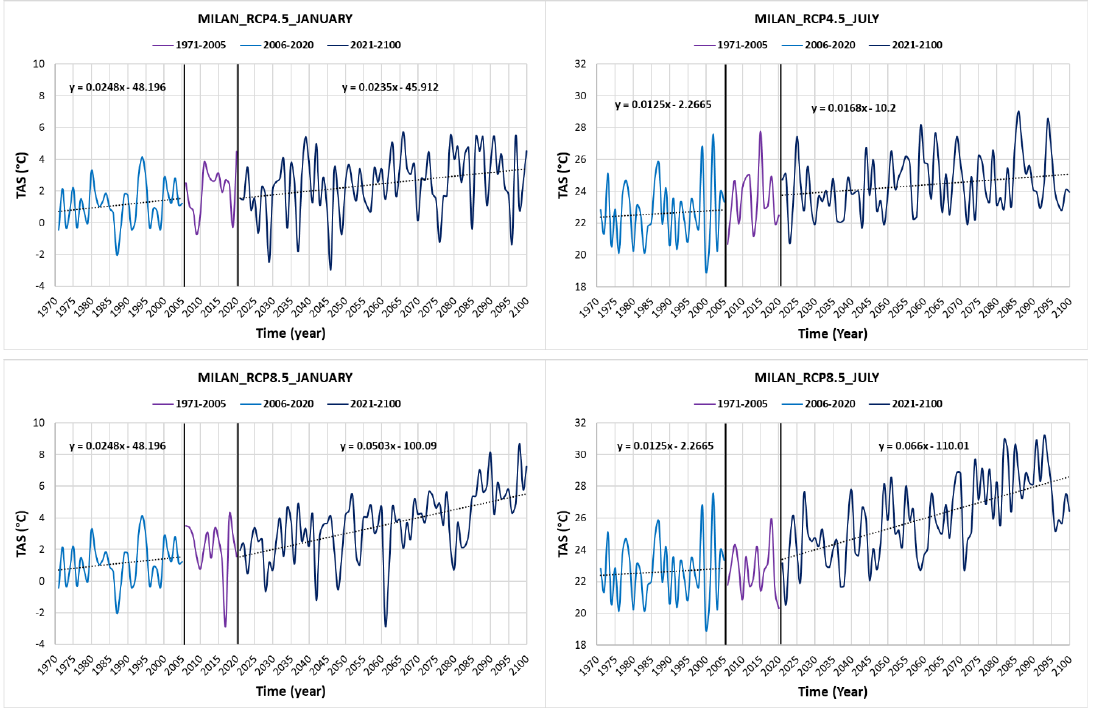
Figure 6. Milan’s monthly average hourly TAS variation in January ( left ) and July ( right ) from 1971 to 2100. ( Top ): RCP4.5, ( bottom ): RCP8.5. to 2100. ( Top ): RCP4.5, ( bottom ):